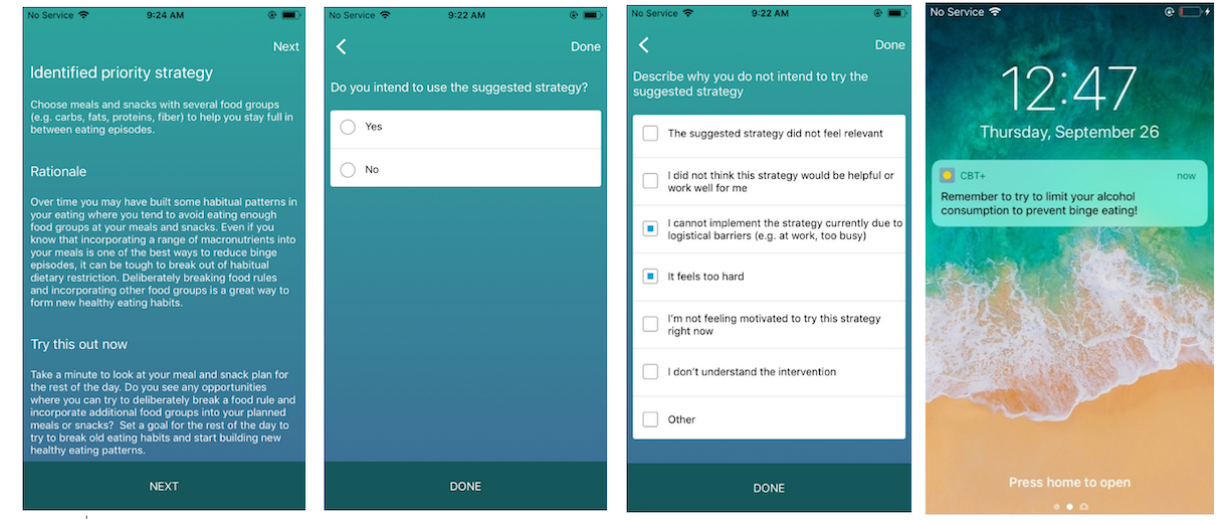
Figure 3. Screenshots of the delivered just-in-time adaptive interventions and follow-up